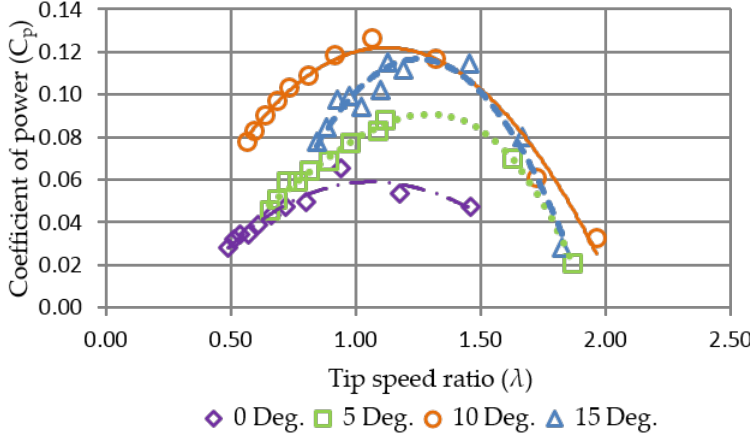
Figure 11. Coefficient of power against tip speed ratio for different pitch angle.